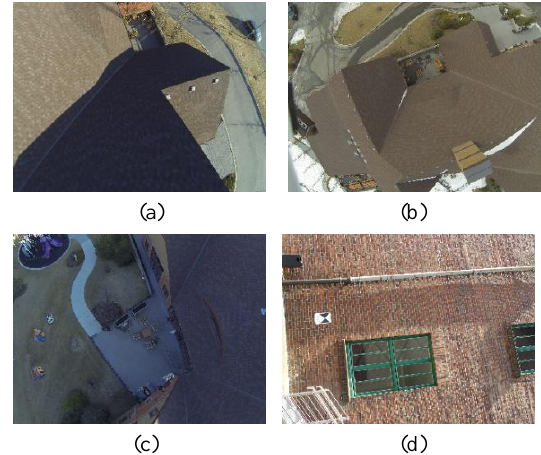
Figure 2. Examples of low quality images: (a) shadowed image, (b) image with high radial distortion, (c) image with low radiometric quality, and (d) image with repeated textures The quality of the collected POS information will be assessed using a well-distributed network of ground control points. The coordinates of these control points are re-estimated using image coordinate measurements and compared to their reference coordinates. The calculated differences in object space represents the overall accuracy of the photogrammetric system’s direct georeferencing components (Cramer et al.,